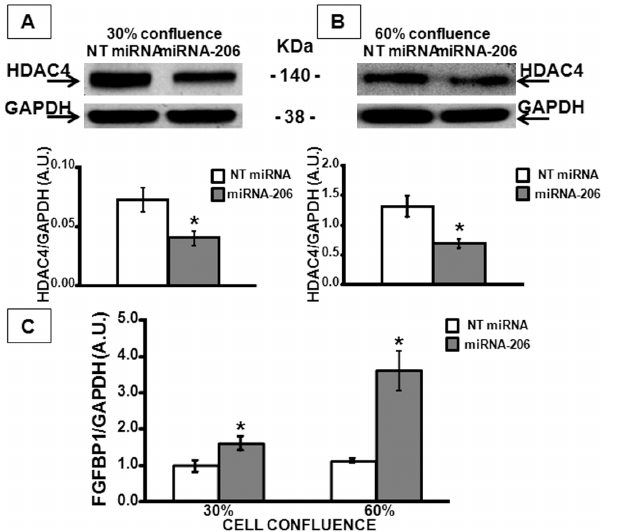
Fig 3. HDAC4 and FGFBP1 expression levels in C2C12 cells transiently transfected with miRNA-206. Panels A-B, representative Western blots displaying HDAC4 protein levels in C2C12 cells transfected at 30% confluence (panel A) and at 60% confluence (panel B) with a mimic miRNA-206 (miRNA-206) and with a non targeting miRNA (NT miRNA) used as control. Graphs below each image report the quantification of HDAC4/ GAPDH protein levels. Panel C, evaluation of FGFBP1 mRNA levels in C2C12 cells transfected at 30% and 60% confluence with miRNA-206 and NT miRNA. * p < 0.05 vs respective control by t-test